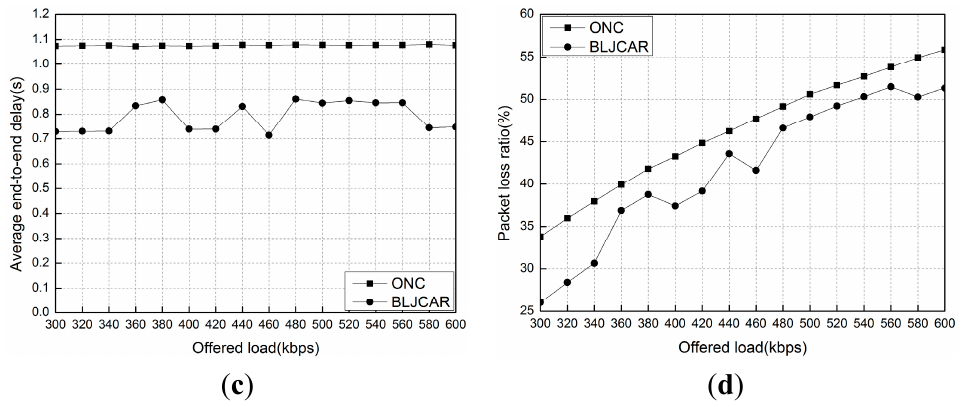
Figure 9. ( a ) Average packet jitter versus offered load; ( b ) Network throughput versus offered load; ( c ) Average end-to-end delay versus offered load; ( d ) Packet loss ratio versus offered